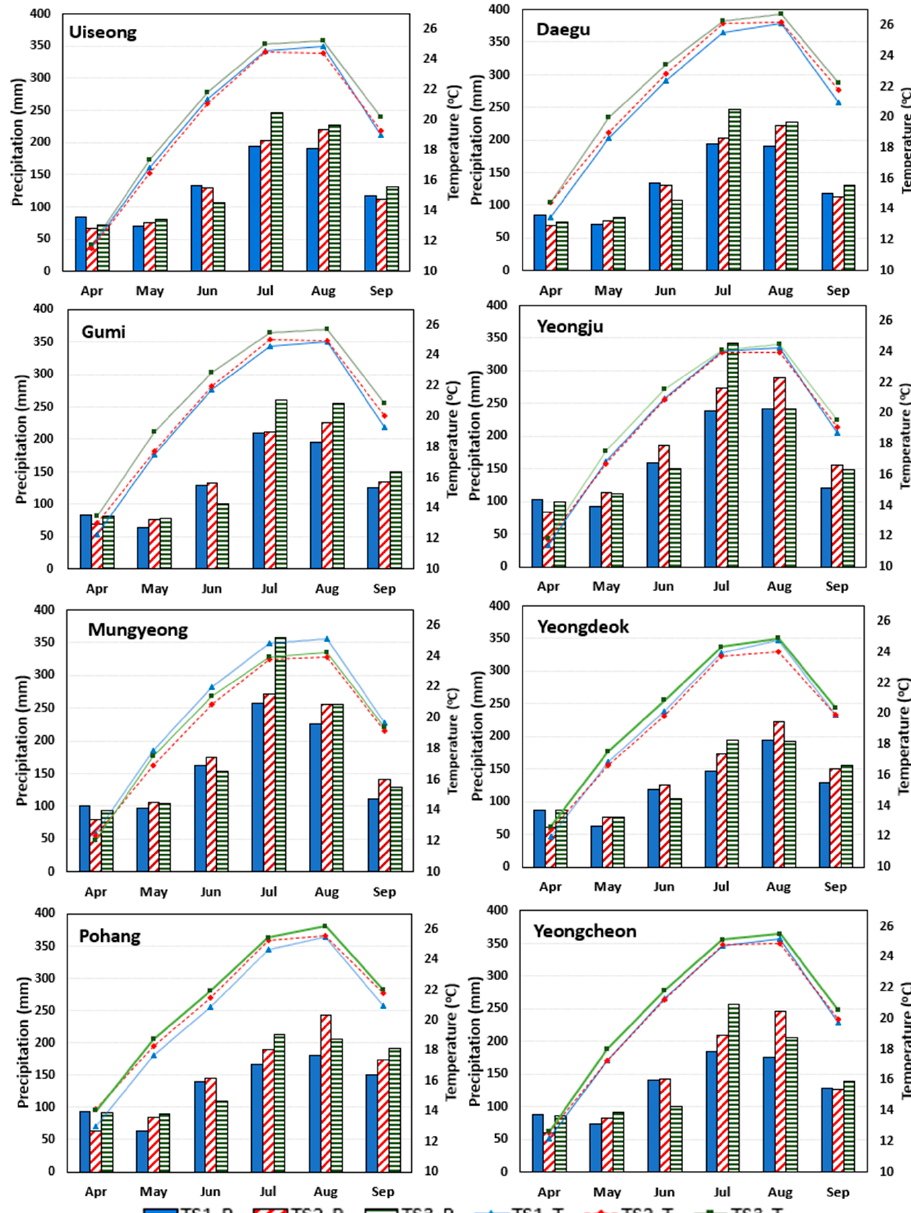
Figure 3. Monthly mean temperature (T mean ) and precipitation (P) in the rice season averaged during the TS1 (1973–1987), TS2 (1988–2002) and TS3 (2003–2017) for the selected meteorological stations in this study.